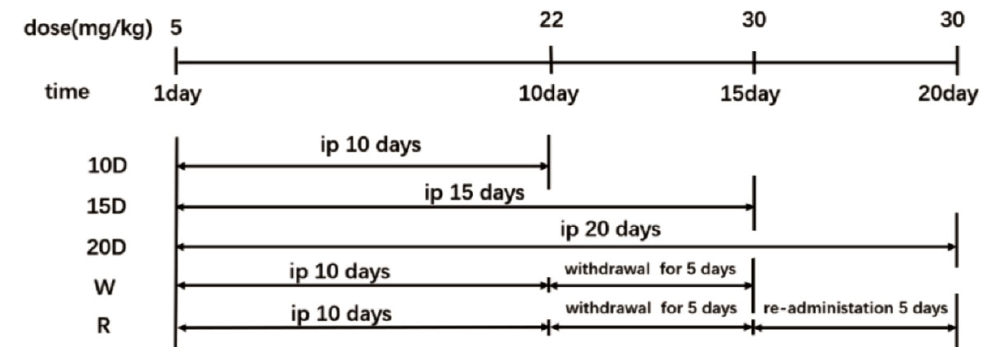
Figure 1. The scheme of drug administration. There are 5 groups in the experiment: 10 ‐ day group: given methamphetamine once a day through intraperitoneal injection at a dose range from 5 mg/kg to 22 mg/kg for 10 days; 15 ‐ day group: given methamphetamine once a day through intraperitoneal injection at a dose range from 5 mg/kg to 30 mg/kg for 15 days; 20 ‐ day group: given meth ‐ amphetamine once a day through intraperitoneal injection at a dose range from 5 mg/kg to 30 mg/kg for 20 days; 15 ‐ day withdrawal group: given methamphetamine once a day through intraperitoneal injection at a dose range from 5 mg/kg to 22 mg/kg for 10 days, then methamphetamine administration stopped; 20 ‐ day relapse group: re ‐ administration 5 days after the withdrawal.